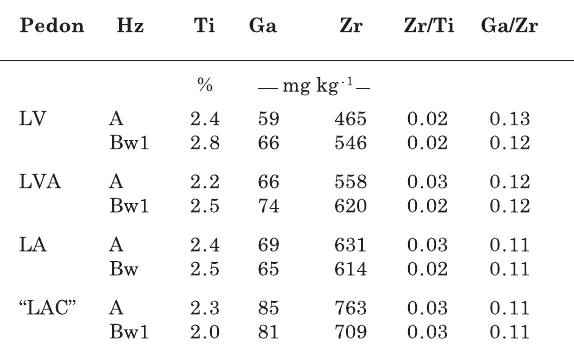
Table 7. Trends and ratios of Ti, Ga and Zr in toposequence soils